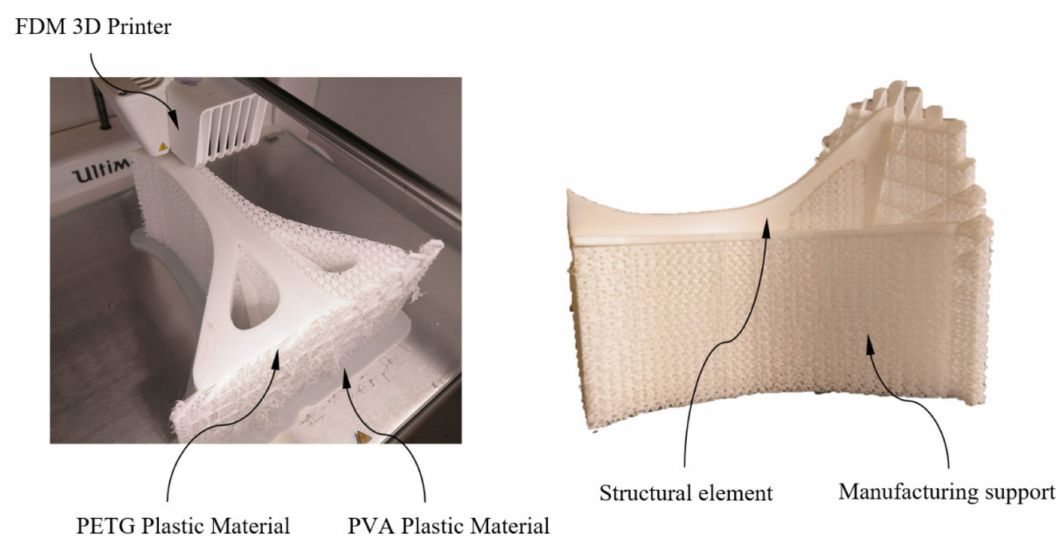
Figure 4. Manufacturing of the structural element under